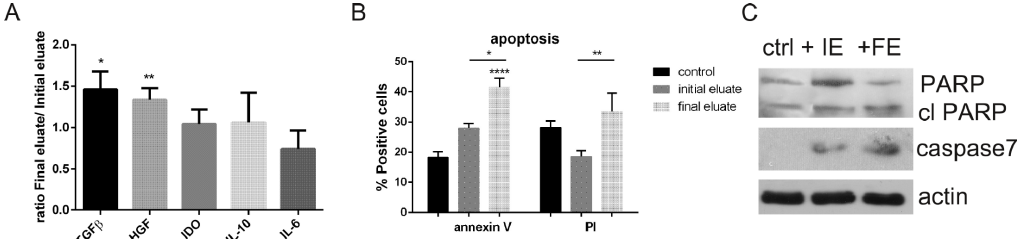
Figure 7. Analysis of the secretome produced by hAFSC fractions. ( A ) Graph representing ELISA tests for TGF β , HGF, IDO, IL-10 and IL-6 analysed in condition medium (CM) produced by initial and final eluted cells obtained from 3 donors. The ratio between final and initial CM is shown. T test statistical analysis was performed to evaluate the difference between CM of final cells compared to the one of initial cells. * p value < 0.05; ** p value < 0.01. ( B ) Graph showing the percentage of PBMCs positive for Annexin V and PI after exposure for 4 days to CM produced by initial and final eluted cells. * p value < 0.05; ** p value < 0.01; **** p value < 0.0001. ( C ) Western blot analysis of lysates of PBMCs exposed to initial (IE) and final eluted (FE) hAFSCs revealed for PARP, caspase 7 and actin as loading control.